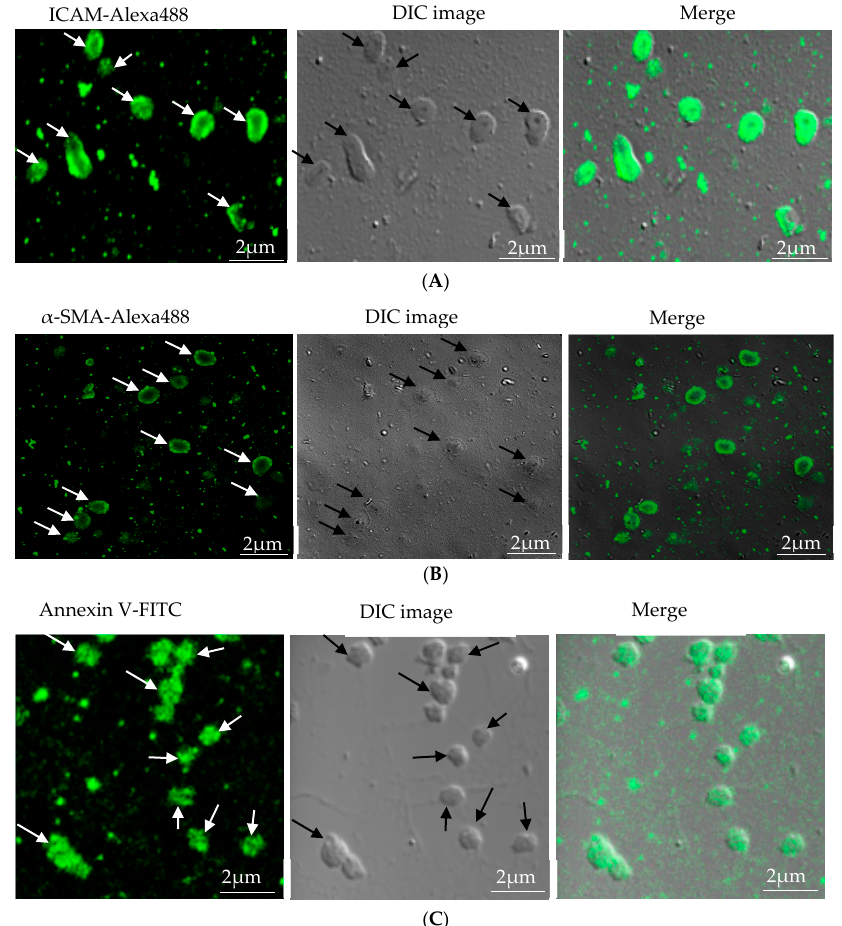
Figure 1. Characterization of microparticles isolated from various cell lines. ( A ) Endothelial microparticles (EC-MP) (shown by arrowhead) obtained from in vitro lipopolysaccharide (LPS)- treated endothelial cell (EC) were stained with ICAM followed by Alexa-488 and photographs were